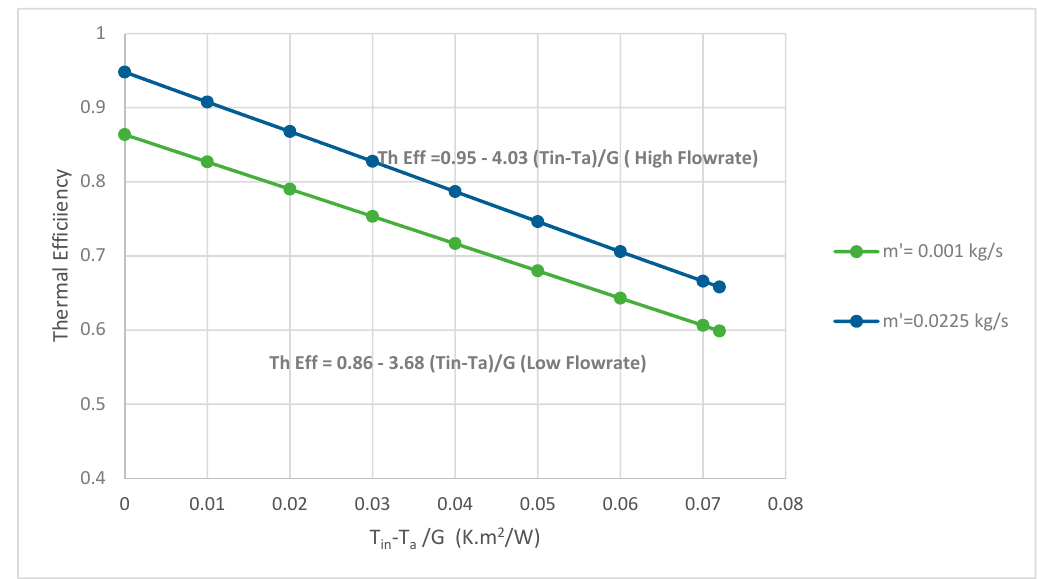
Figure 17. Thermal efficiency of FPC versus energy loss parameter.